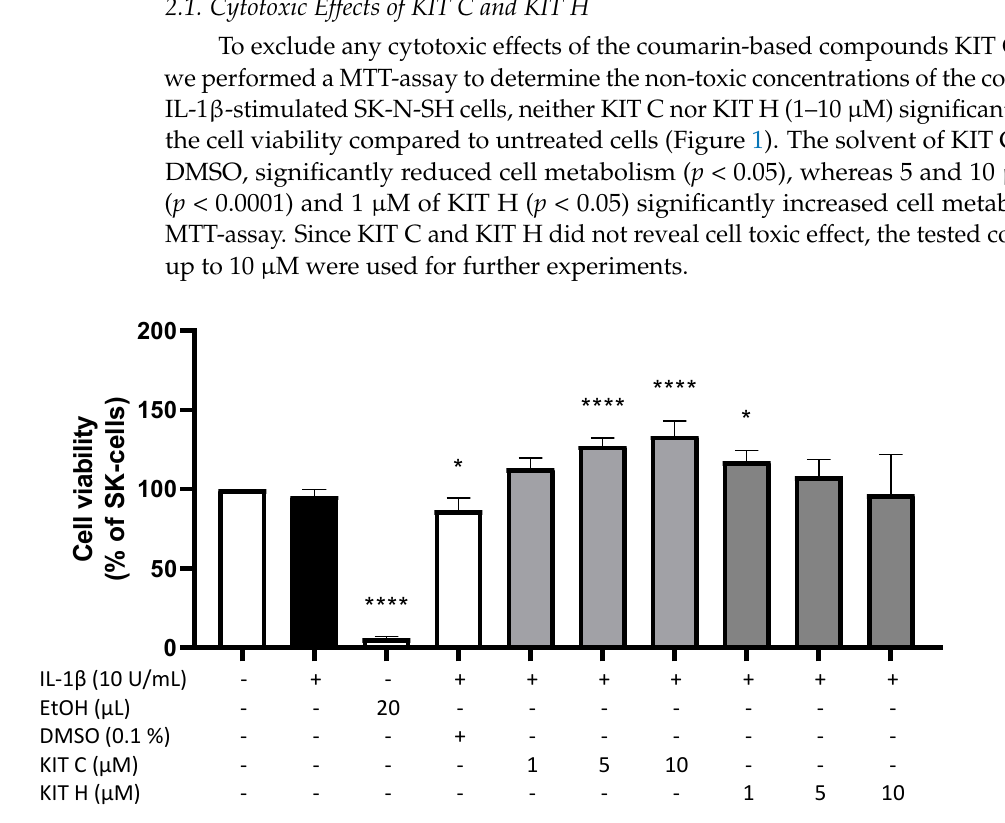
Figure 1. Effects of KIT C (light grey) and KIT H (dark grey) on cell viability of IL-1 β -stimulated SK-N-SH cells. Cell viability was measured after 24 h of treatment by change in color due to MTT-oxidation. Values are presented as the mean ± SD of four independent experiments. Statistical analysis was performed using one-way ANOVA with Dunnett’s post hoc test with * p < 0.05 and **** p < 0.0001 compared to untreated cells.